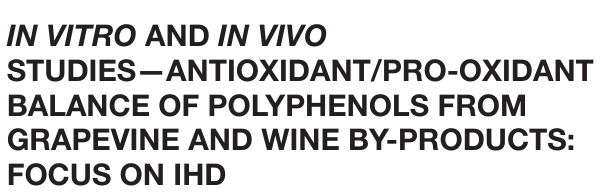
smooth muscle, and to dilate the blood vessels (58). Beta-blockers can also be used to reduce myocardial oxygen